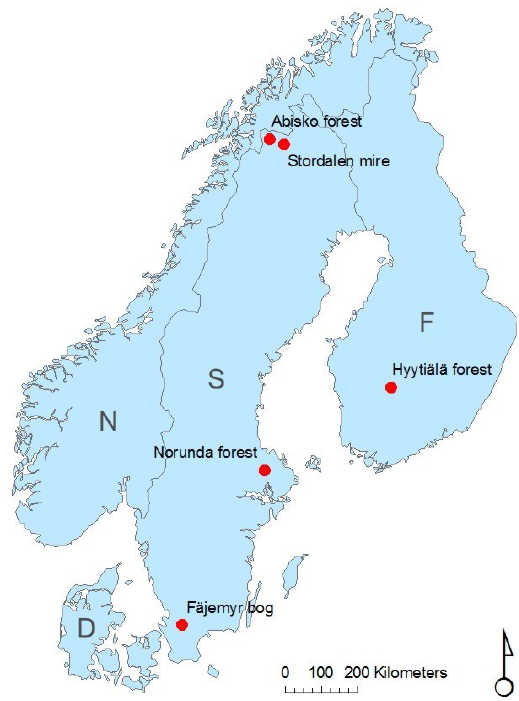
Figure 1. Sampling sites (red dots). D = Denmark, F = Finland, N = Norway, and S =